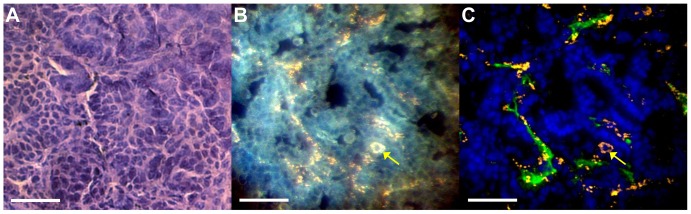
Lung tumor histology.(A) H&E staining of a lung tumor. (B) Darkfield microscopy of a different section of the same tumor. (C) The overlay of darkfield and fluorescence images with the nanoparticles from the darkfield image in orange, the CD31 stain in green and DAPI in blue. The yellow arrow denotes a cell (most likely a macrophage) with cytoplasm filled with nanoparticles. The scale bar represents 50 µm in all panels.